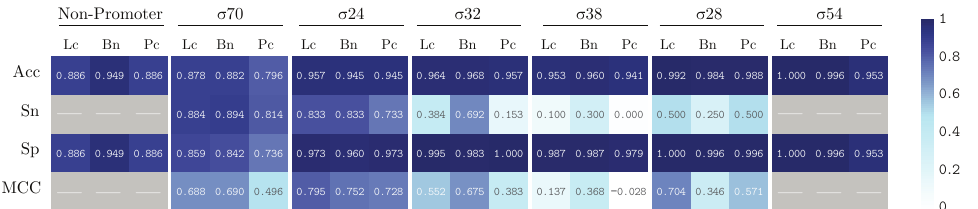
Figure 6. Performance on the test dataset for PromoterLCNN (Lc), pcPromoter-CNN (Pc) and iPromoter-BcNN (Bc), measuring accuracy (Acc), sensitivity (Sn), specificity (Sp) and Matthews correlation coefficient